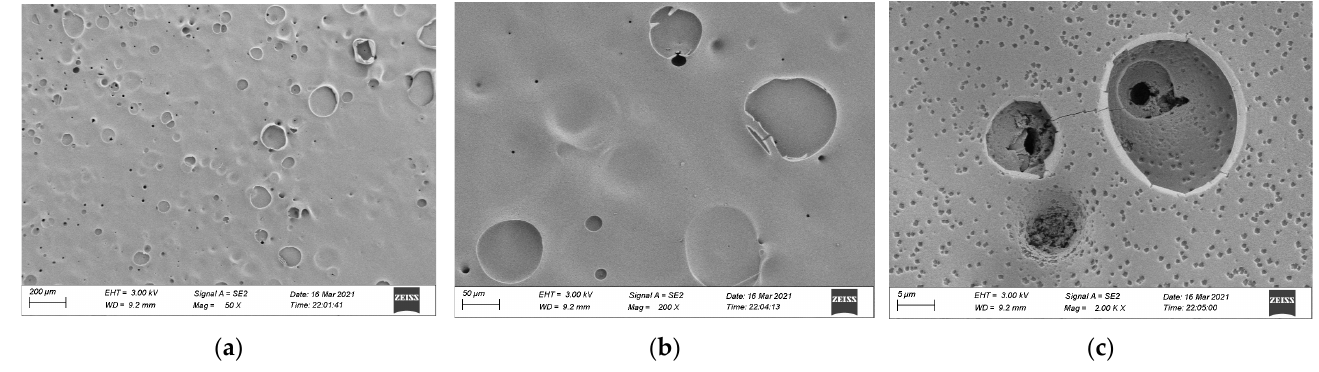
Figure 14. Morphology of residual carbon after the cone calorimeter test of epoxy resin: ( a ) 50×, ( b ) 200×, and ( c ) 2000× magnification.